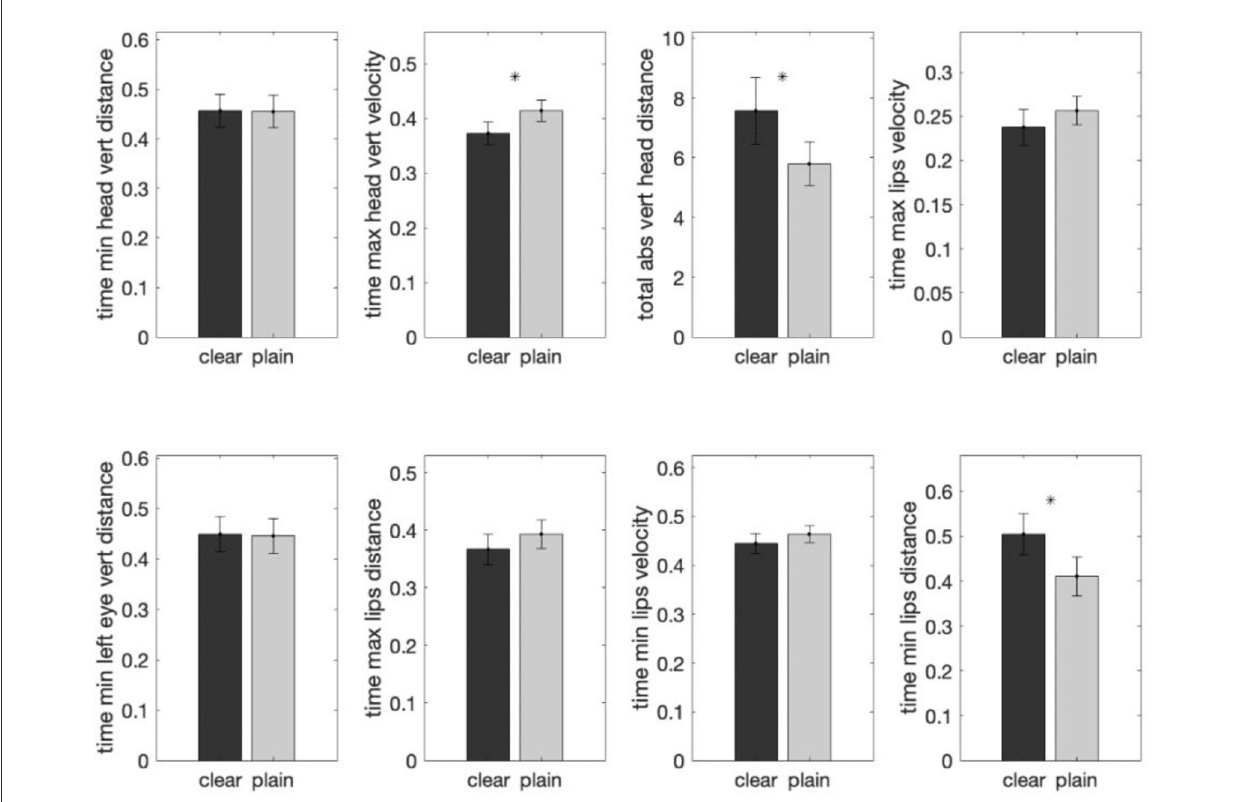
FIGURE11 Comparisons of the group means of each of the eight important features (determined by random forest analyses) in clear and plain style in Tone 4. The y-axis shows the average normalized feature value for that particular style group. Three features were found to exhibit a statistically significant difference between the two speech styles by mixed-effects modeling. The error bar on each of the bar plots shows the standard error. A * above a bar represents a p-value smaller than